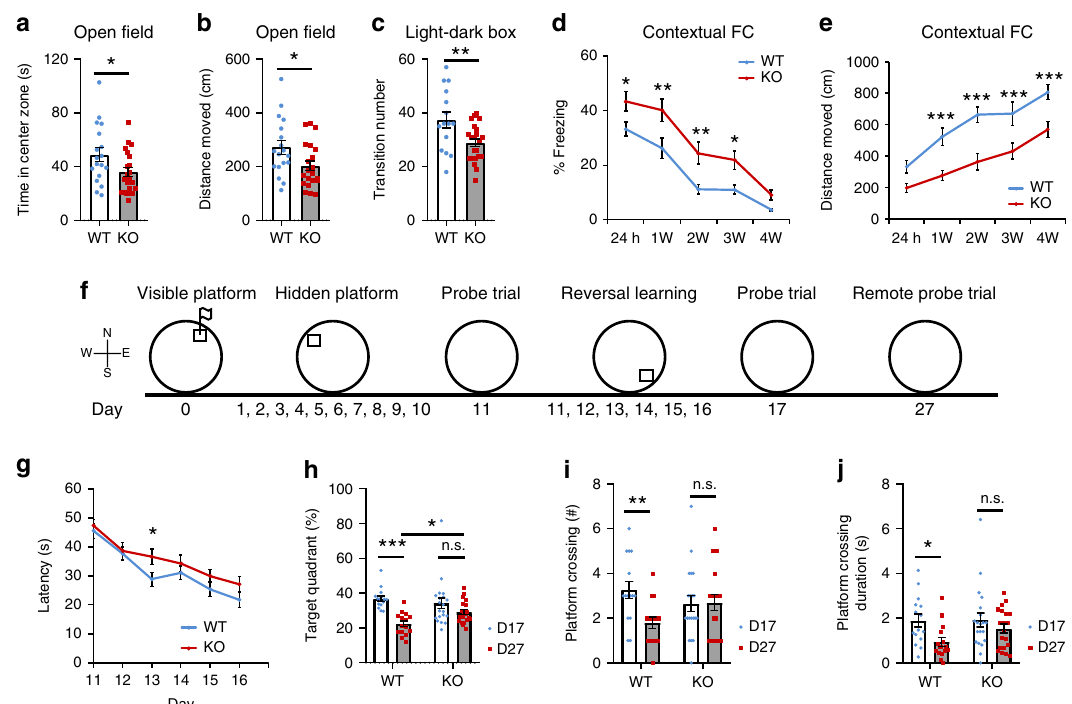
Fig. 6 Casp2 KO mice display elevated anxiety, enhanced fear memory and impaired cognitive fl exibility. a , b Time spent and distance traveled in the center zone in open fi eld tests. n = 18 WT mice and 21 KO mice. c Transition numbers between two chambers in light – dark exploration tests. n = 15 WT mice and 22 KO mice. d , e Percentage of time spent in freezing and distance traveled in contextual fear conditioning (FC) tests. n = 18 WT mice and 22 KO mice. f Schedule for training sessions and probe trials in water maze tests. g Latency for mice to locate the hidden platform during reversal spatial learning. n = 15 WT mice and 21 KO mice. h Percentage of time spent in the target quadrant during the 2nd probe trial and the remote probe trial. n = 15 WT mice and 20 KO mice. i Number of time when mice cross the location of the hidden platform during the 2nd probe trial and the remote probe trial. n = 15 WT mice and 20 KO mice. j Performance at the probe trials. Duration spent in crossing the location of the hidden platform was signi fi cantly shorter on day 27 than on day 17 in WT mice but not KO mice. Two-tailed Student ’ s t test for a – c . Two-way ANOVA with Bonferroni post hoc test for d – j . * p < 0.05, ** p < 0.01 and *** p < 0.001. Data are presented as mean ± SEM. Source data are provided as a Source Data fi